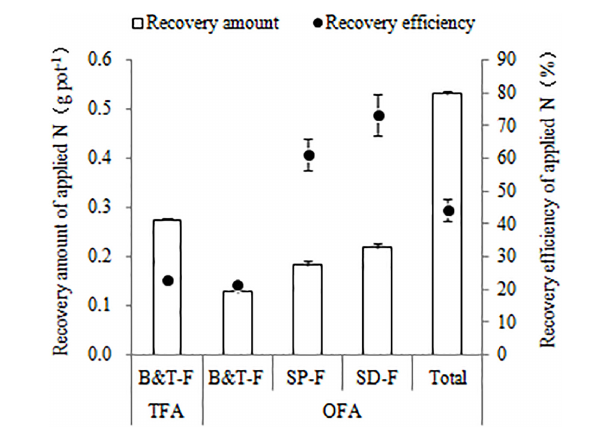
FIGURE 1 | Quantity and efficiency of applied nitrogen recovery (2014, 15 N tracing). TFA: traditional nitrogen fertilizer application, OFA: optimized nitrogen fertilizer application. B&T-F: base and tillering fertilizers; SP-F: spikelet-promoting fertilizer applied at jointing stage; SD-F: spikelet-developing fertilizer applied at 15–20 days after jointing stage. Data represent mean values of three biological replicates ±